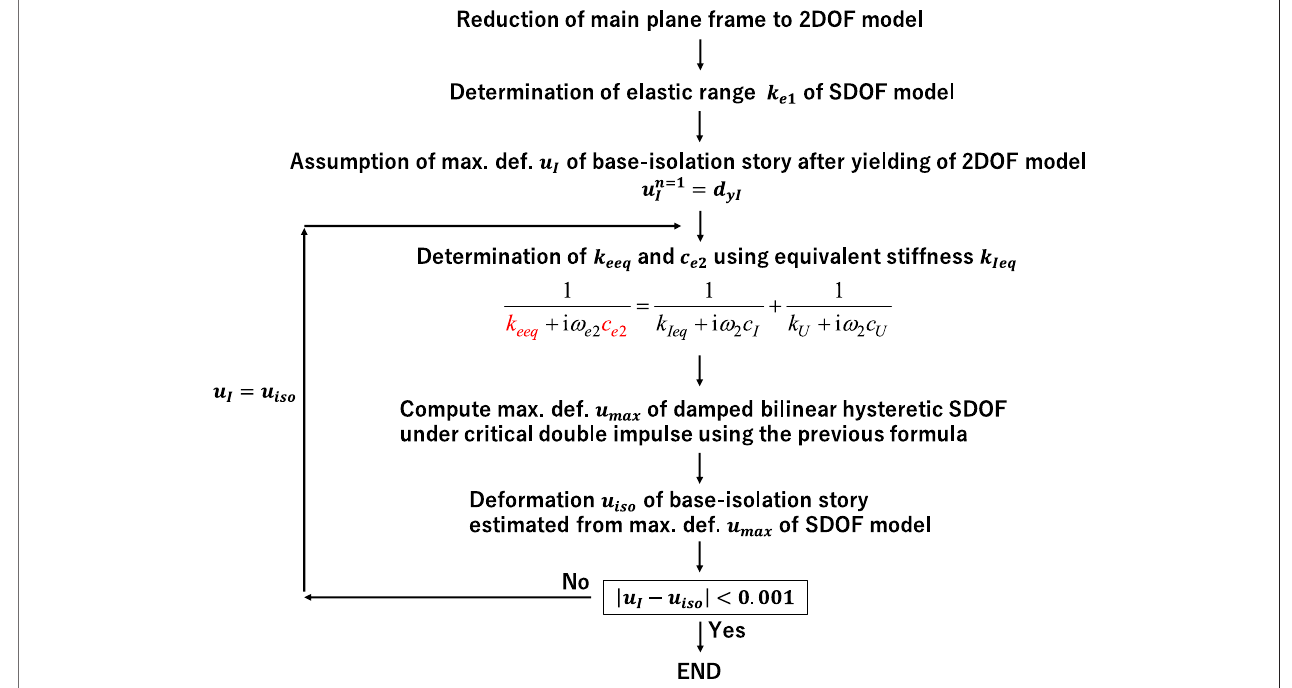
FIGURE 5 | Flow for determining equivalent